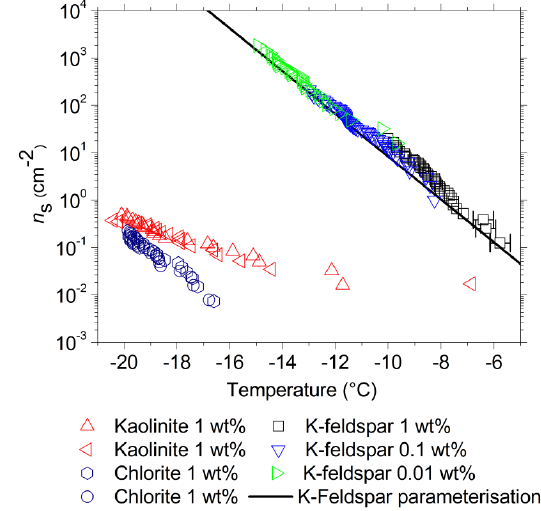
Figure 7. n s values for K-feldspar, kaolinite and chlorite. Example temperature error bars are shown on the first three points of the 1wt% K-feldspar experiment. Estimated uncertainty in n s due to uncertainty in the surface area of material per droplet is estimated at ± 15% and is too small to be shown on the chart. The K-feldspar parameterisation is from Atkinson et al.